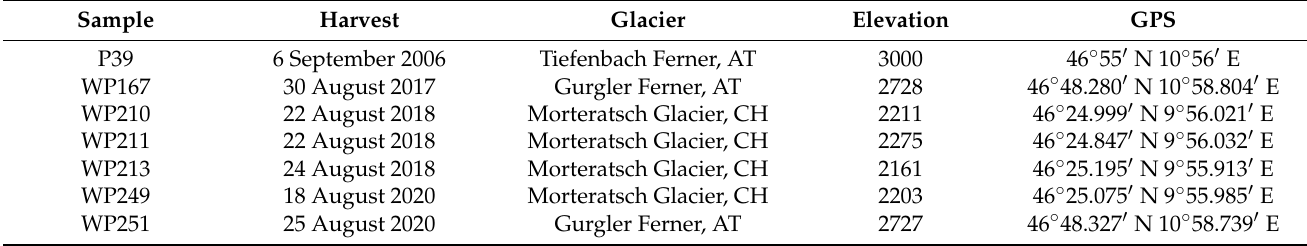
Table 1. Glacial algal sample codes, collection date, sampling sites, elevation (in meters above sea level) and geographic position